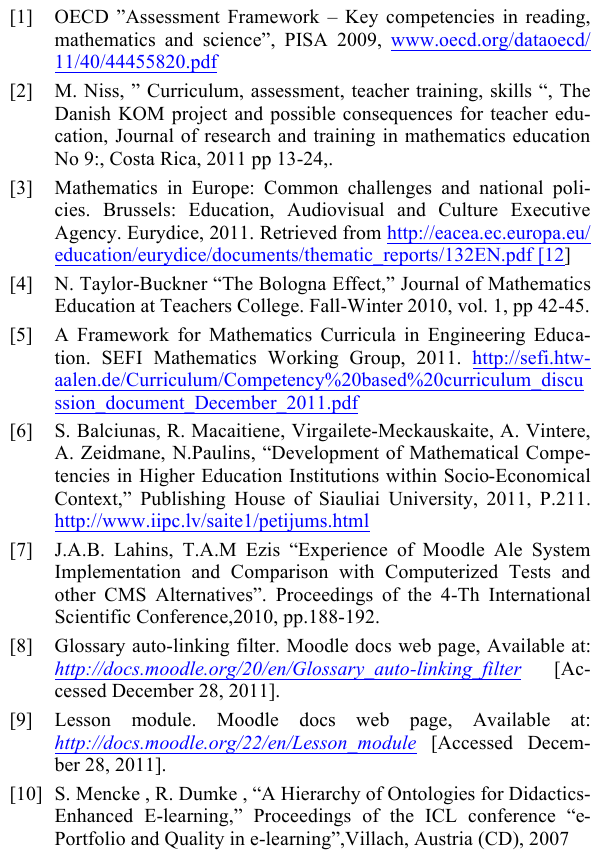
Figure 9. Importance of Frameworks of Practical Problem Solving in